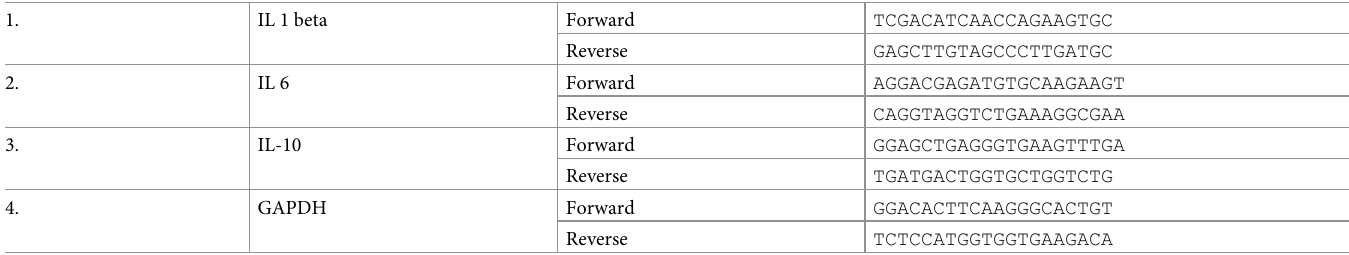
Table 4. The sequence of primers